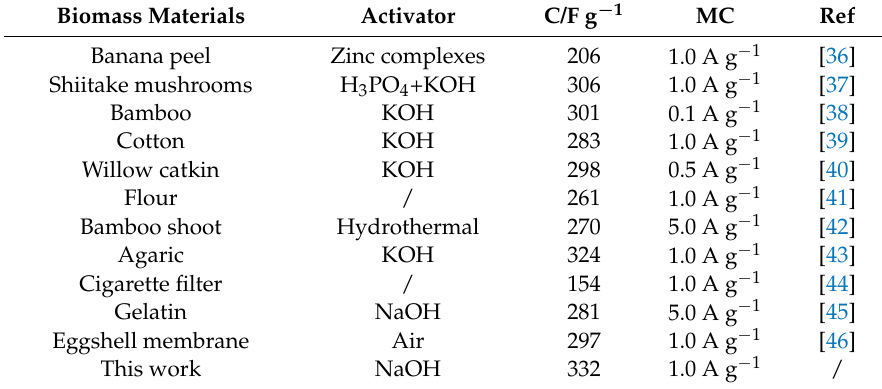
C: Specific capacitance. MC: Measurement